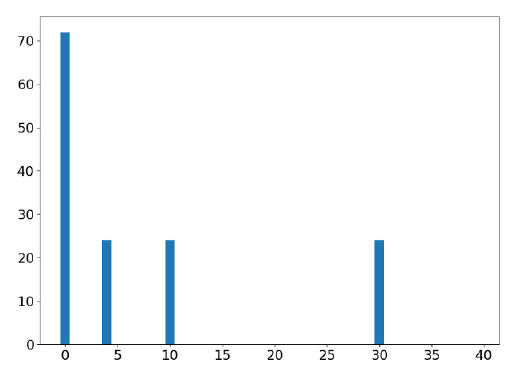
Figure 7 . # of n -generation models w.r.t. n H for search (I) with h 1 ; 1 = 3. The horizontal and vertical axes represent n H and the number of models, respectively.